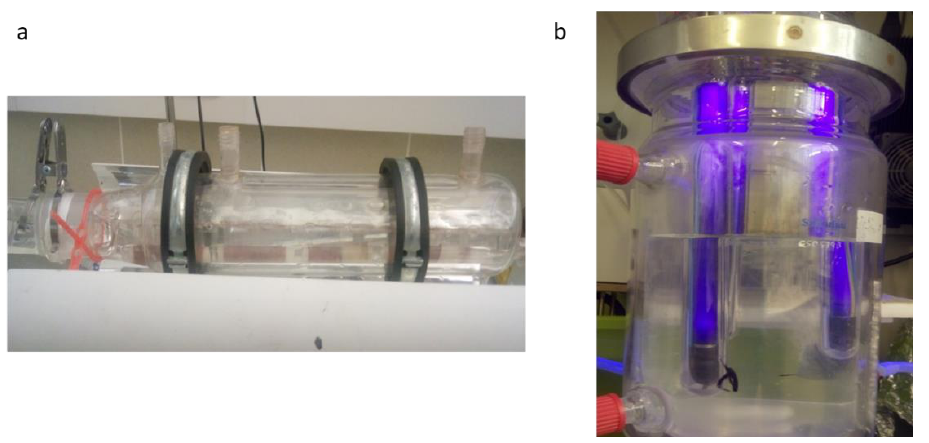
Figure 2. ( a ) Sunlight photoreactor and ( b ) UVA reactor.